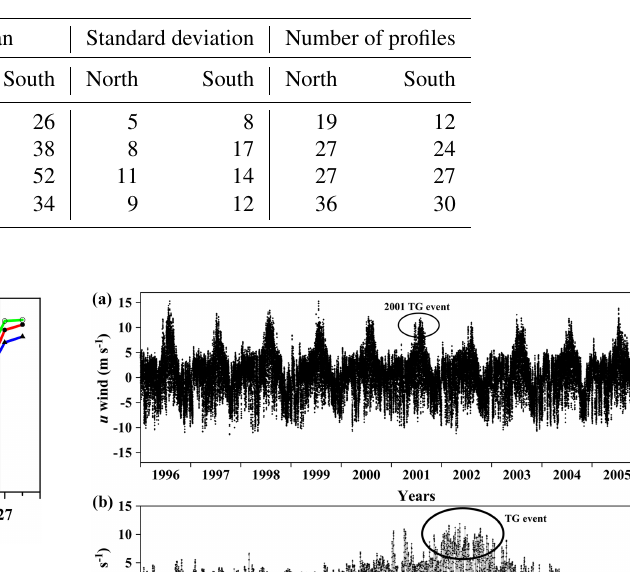
Figure 6. Correlation between major forces and MLD. Shaded re- gions represent locations of coinciding drops in correlation.